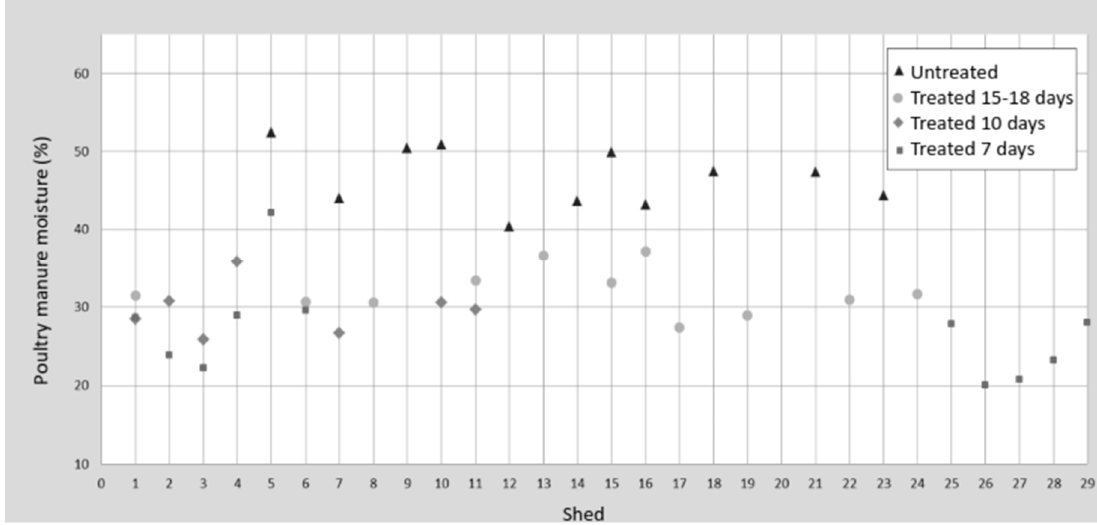
Figure 1. Poultry manure moisture of the all test